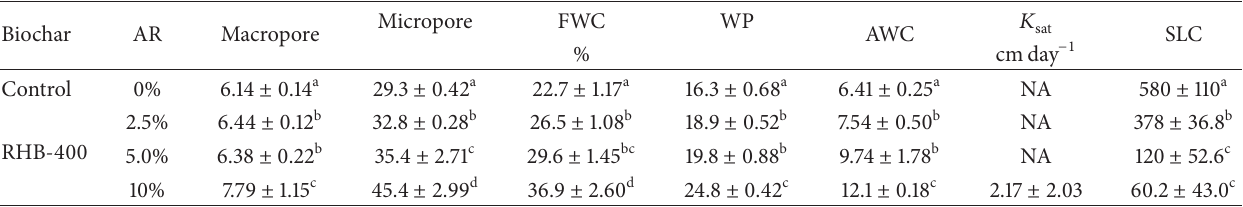
Table 3: Mean soil volumetric moisture contents measured at different matric potentials, macropores, and saturated water conductivity of the control and biochar-amended soils after incubation ( 𝑛 = 3).